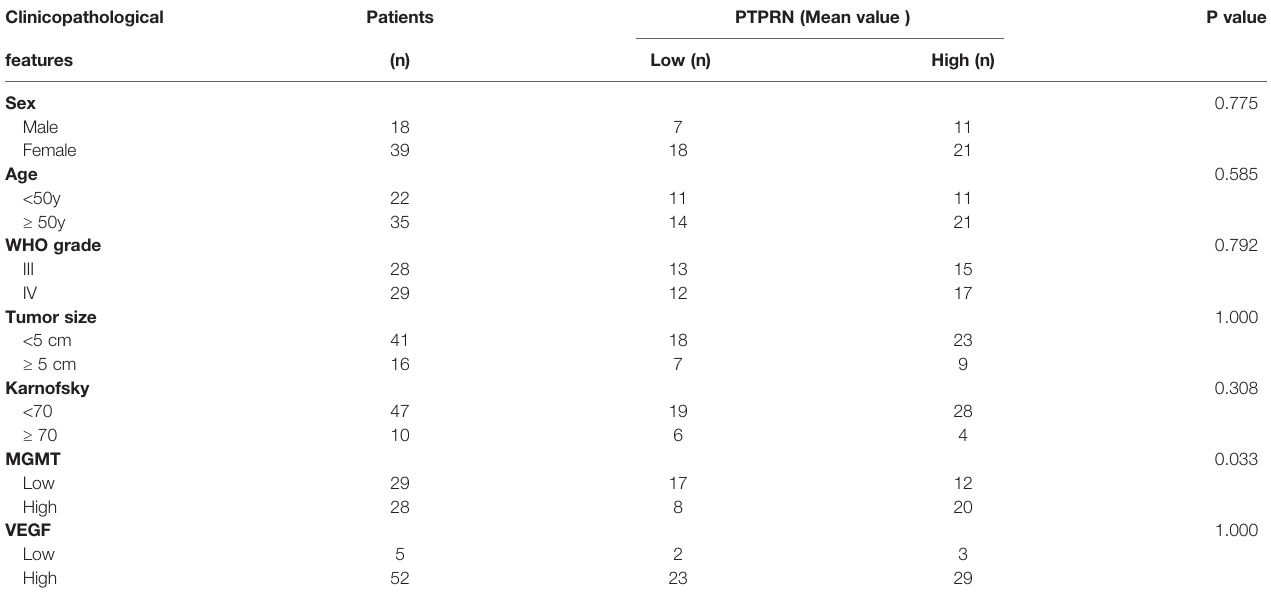
TABLE 1 | The relationship between PTPRN expression with clinicopathological features. Clinicopathological